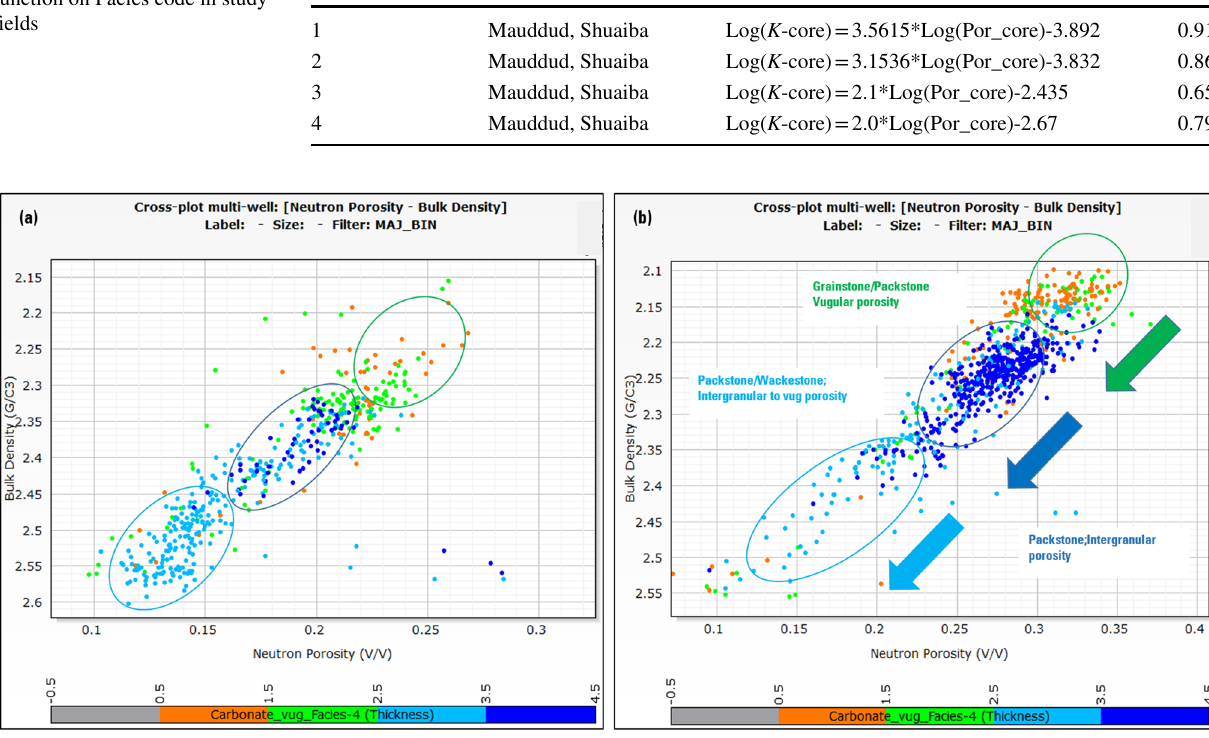
Fig. 8 NPHI-RHOB distribution in a Mauddud Formation and b Shuaiba